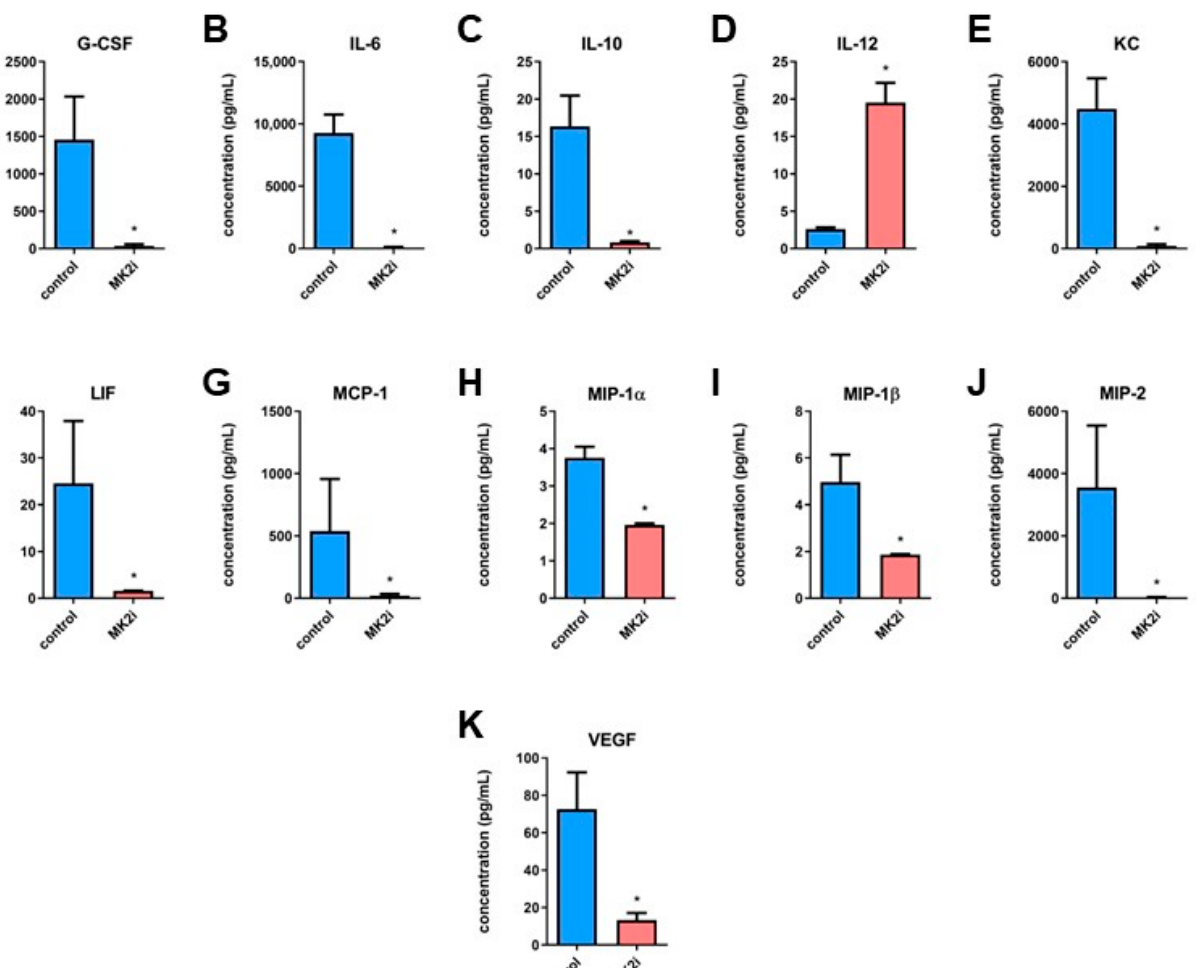
Figure 2. MK2 inhibition affects production and secretion of cytokines and chemokines in PNETs. Tumor supernatants were examined by multiplex array for the concentration of G-CSF ( A ), IL-6 ( B ), IL-10 ( C ), IL-12 ( D ), KC ( E ), LIF ( F ), MCP-1 ( G ), MIP-1 α ( H ), MIP-1 β ( I ), MIP-2 ( J) and VEGF ( K ) from tumors obtained from RipTag2 mice treated with DMSO (control, blue) and MK2 inhibitor (MK2i, red). Data are presented as means ± SEM; * p < 0.05 vs. control; n = 6 in each group.